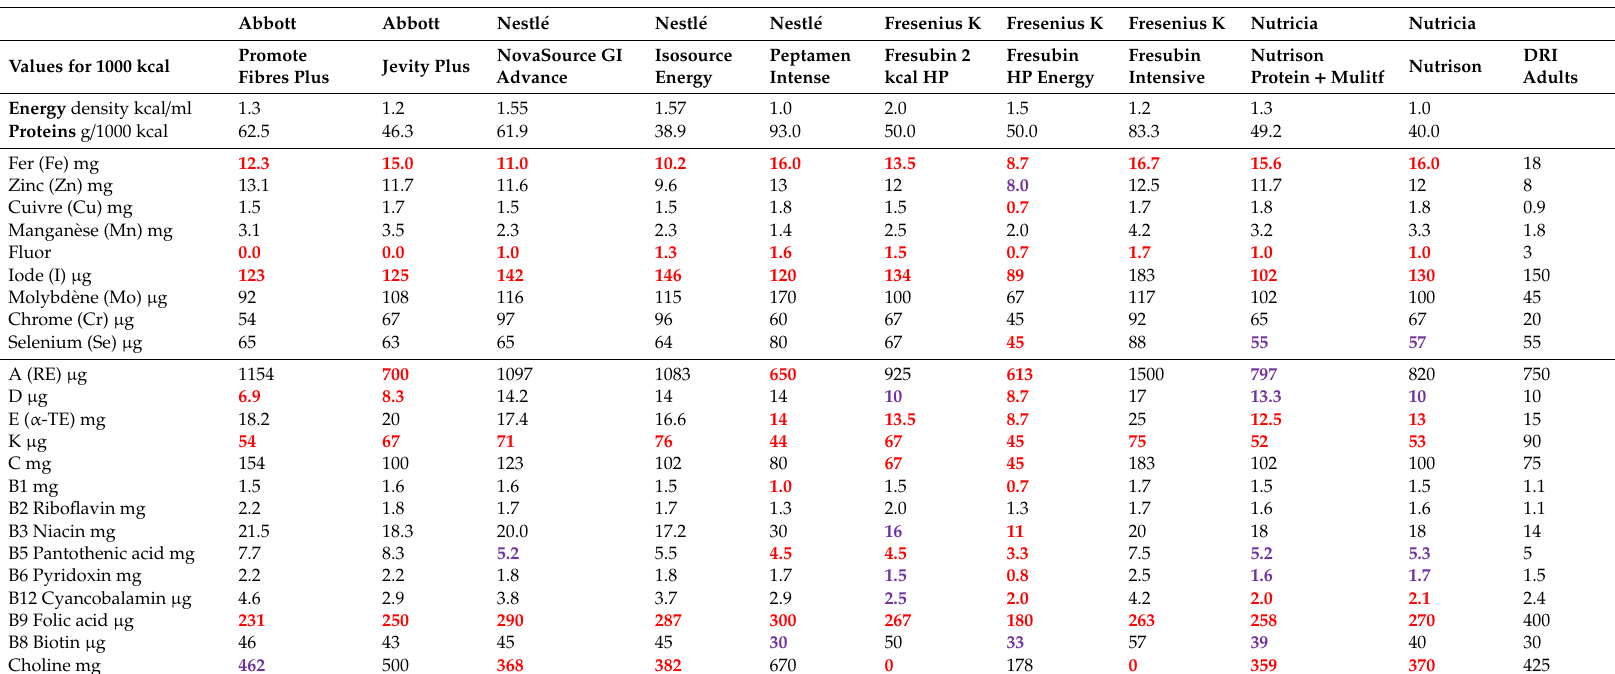
Table 3. Energy, protein and micronutrient data for 1000 kcal for a selection of frequent products available on the Swiss market compared to the dietary reference intakes (DRI). The values which are below the DRI appear in red and bold characters; in violet-bold, those for which DRI is just